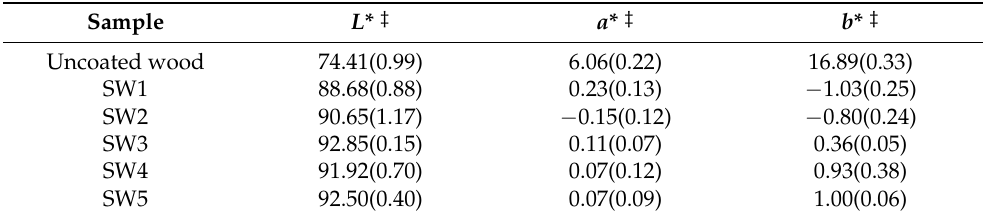
Table 4. Surface CIELAB color space parameters of the coatings at the surface of beech wood (application rate 220 g · m − 2